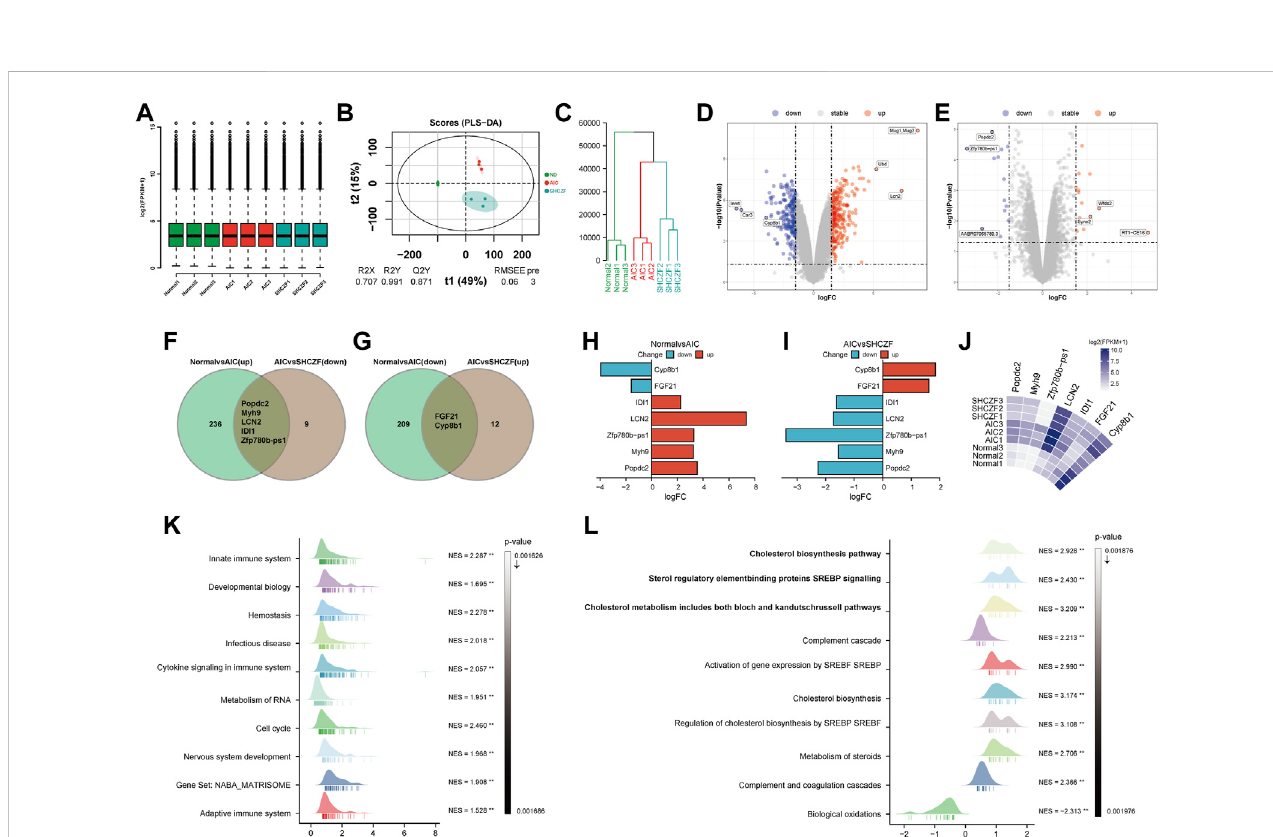
FIGURE 3 The results ofbioinformatics analysis. (A) Boxplot, (B) PLS-DA plot, (C) Dendrogram, (D,E) Volcano plots, (F,G) Veen plots, (H – J) Crucial gene expression analysis plots, (K,L) GSEA analysis results.